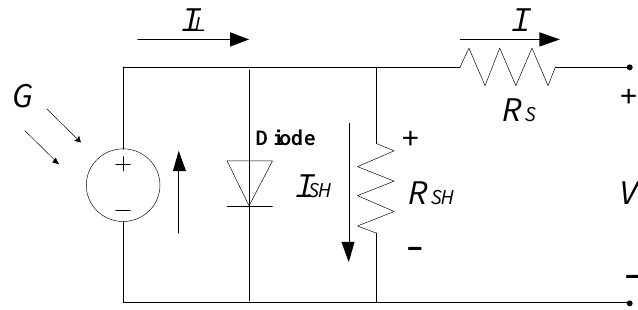
Figure 1. Equivalent circuit of a photovoltaic (PV)